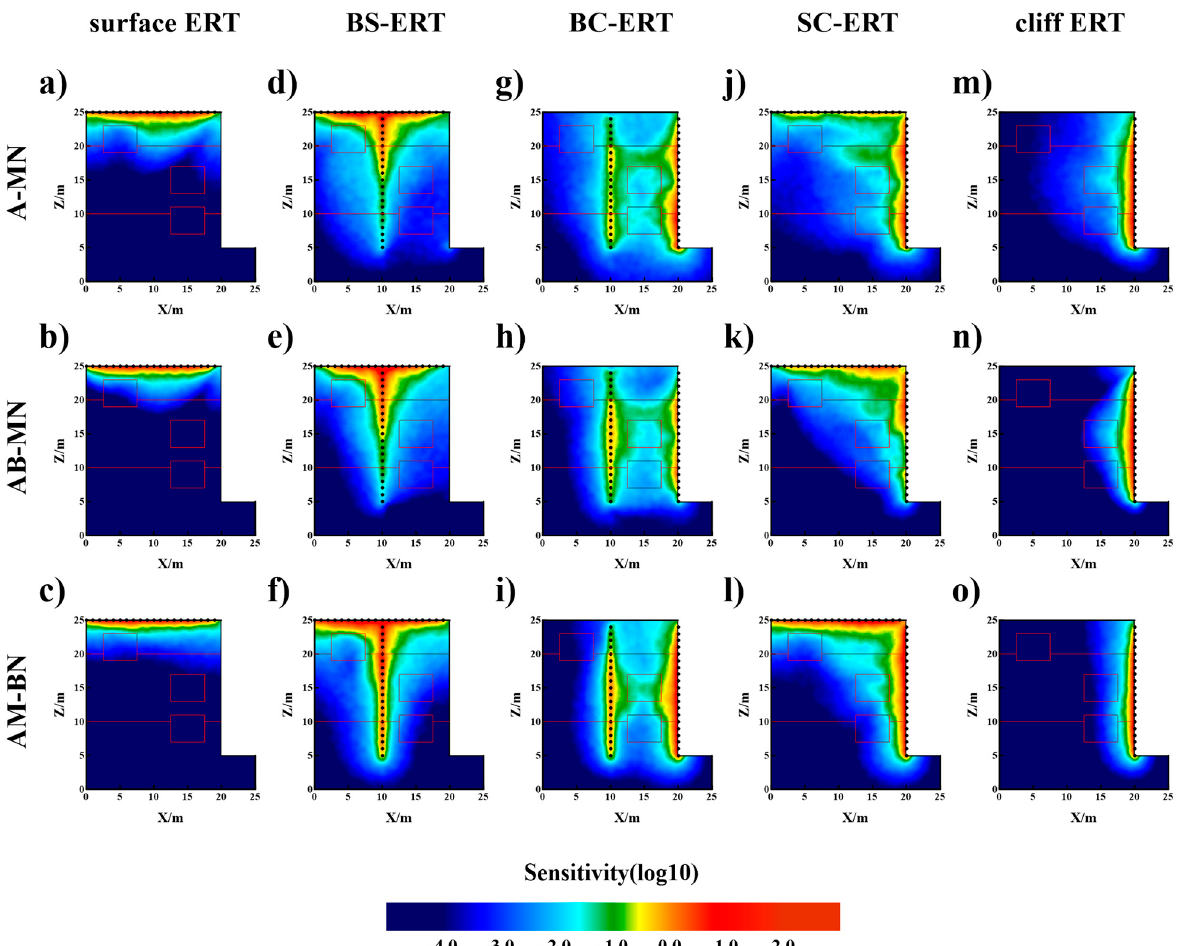
Figure 4. Sensitivity patterns of three configurations in five ERT schemes: ( a – c ) surface ERT scheme, ( d – f ) BS-ERT scheme, ( g – i ) BC-ERT scheme, ( j – l ) SC-ERT scheme, ( m – o ) cliff ERT